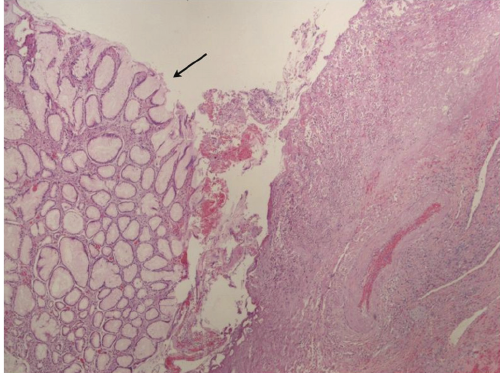
F 2: Magni�ed view of hyperplastic gastric